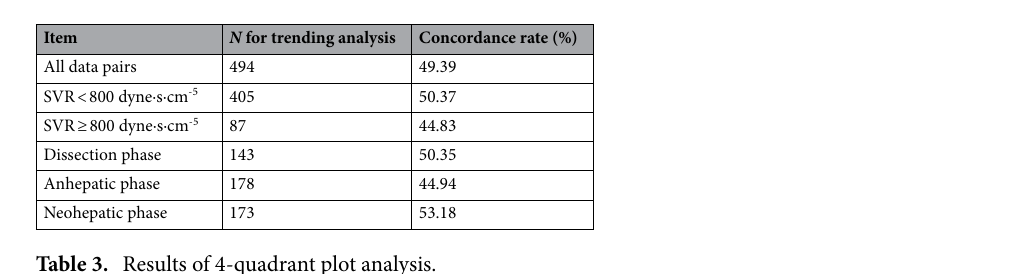
Table 3. Results of 4-quadrant plot